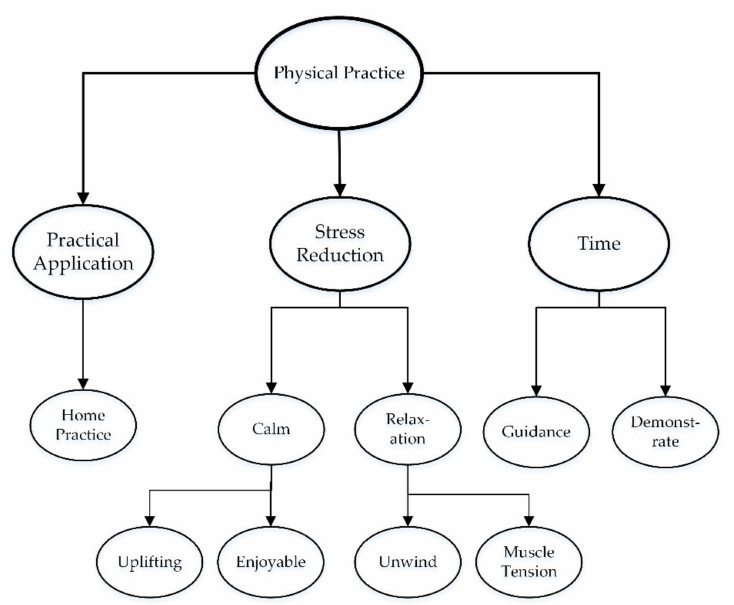
Figure 5. Graphic summary of the themes and sub-themes from the participant post-session feedback (session